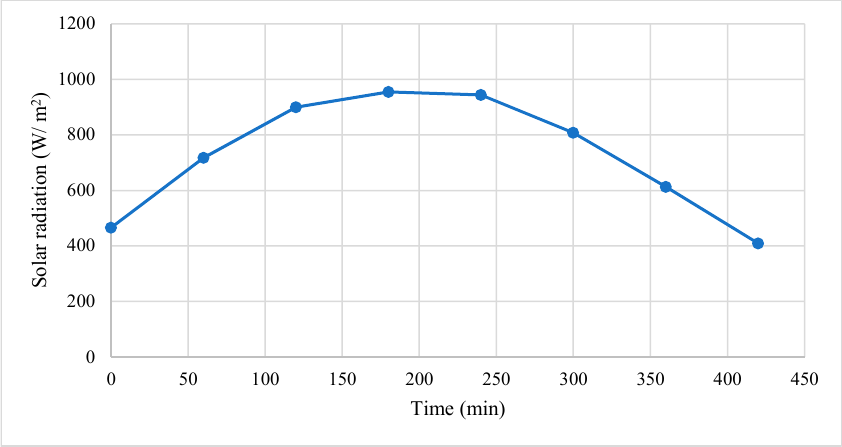
Figure 4. Variation of solar radiation with the time of day when drying mango slices. Relative air humidity under the greenhouse and drying air temperatures inside green- house dryers are shown in Figures 5 and 6. The relative humidity of the air under the greenhouse ranged from 19.8% to 67.2%. The drying air temperature recorded inside the greenhouse ranged from 26.7 to 59.1 ◦ C. During the drying process, the moisture content of the mango slices was reduced from 85.5% wb to 12.4% wb within 1 day (7 h) of exposure in greenhouse solar dryers. The hot air dryer showed a higher drying temperature than that of greenhouse solar dryers. The total time of drying using hot air dryers was lower at 1.5 h (at 70 ◦ C for 1 h, followed by 90 ◦ C for 30 min). In the greenhouse solar drying system, solar radiation was transmitted and absorbed by air and the concrete floor, and then collected in the system rather than reflected to the environment due to the parabolic shape and double layer of the polycarbonate sheet [13]. The temperature in this dryer is directly related to the solar radiation. Thus, increased solar radiation increases air temperature. The relative humidity (%) of the air inside greenhouse solar dryers decreased when the temperature increased. When considering mango slices of this study, one sunny day was reasonably sufficient to finish the drying process using greenhouse solar dryers, similar to the study of Pott et al.